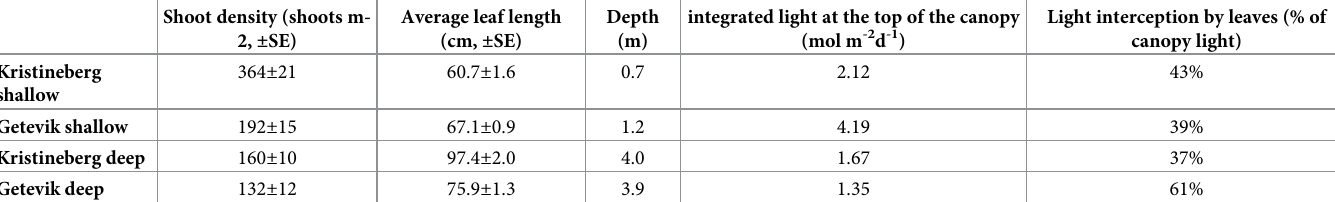
Table 1. Biometrics, depth, light at top of the canopy and the percentage of light that was intercepted at the leaf surface.